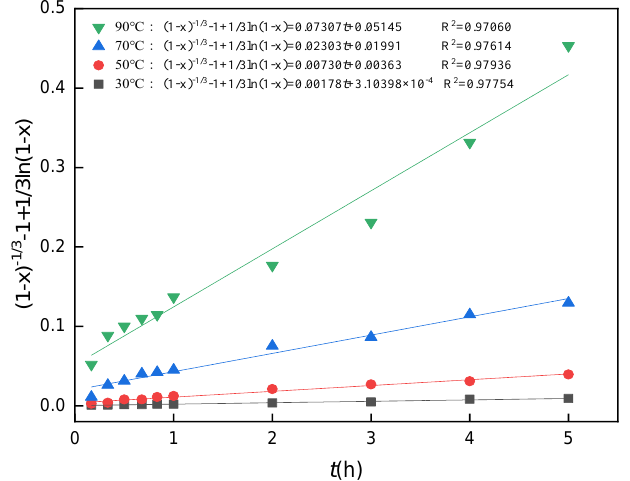
Figure 18. Relationships between 1 − (1 − x) 1/3 and time of iron ions.